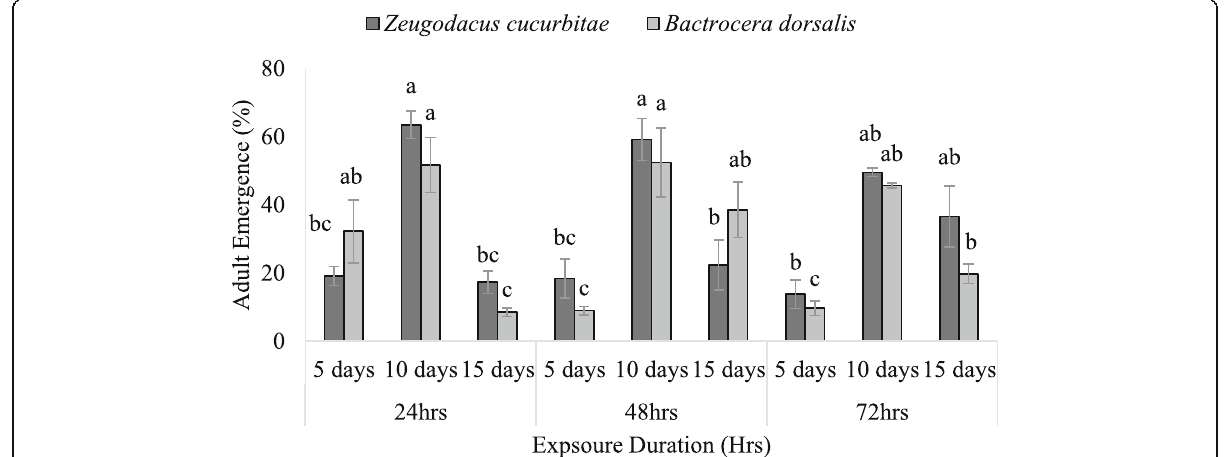
Fig. 3 Adult emergence of Dirhinus giffardii after 24, 48, and 72 h exposures subjected for Zeugodacus cucurbitae pupa and Bactrocera dorsalis pupae. Means followed by similar letter are not significantly different at 0.05% level of significance (for white and black columns)